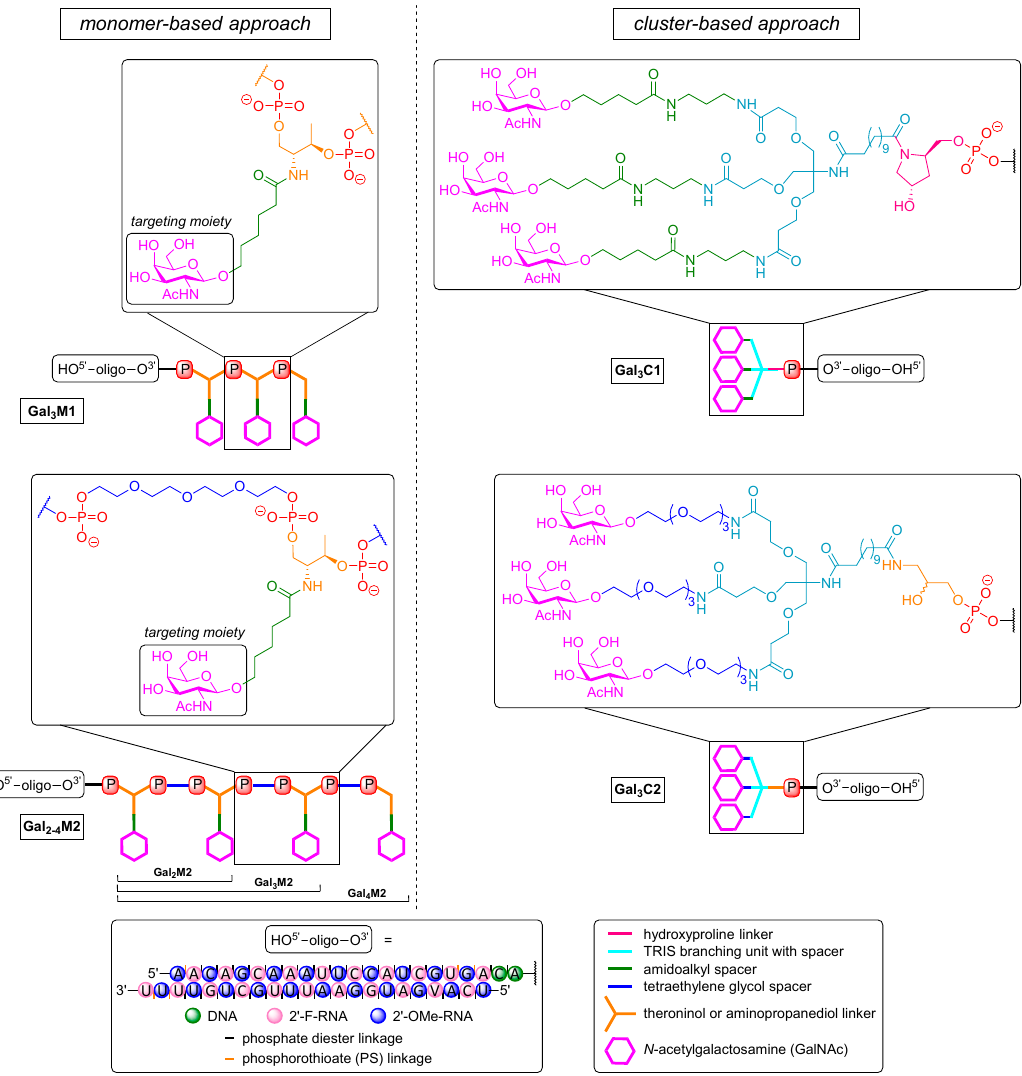
Figure 5. Overview of GalNAc conjugate structures targeting endogenous cyclophilin B. ( Left ) ‘monomer-based’ Gal 3 M1 and Gal 2–4 M2 are clusters constructed by successively reacted GalNAc-derived phosphoramidites with (M2) and without (M1) TEG spacer. ( Right ) the ‘cluster-based’ novel Gal 3 C2 unit (aminopropanediol-based) in comparison to the clinically studied Gal 3 C1 motif (prolinol-based) [321].